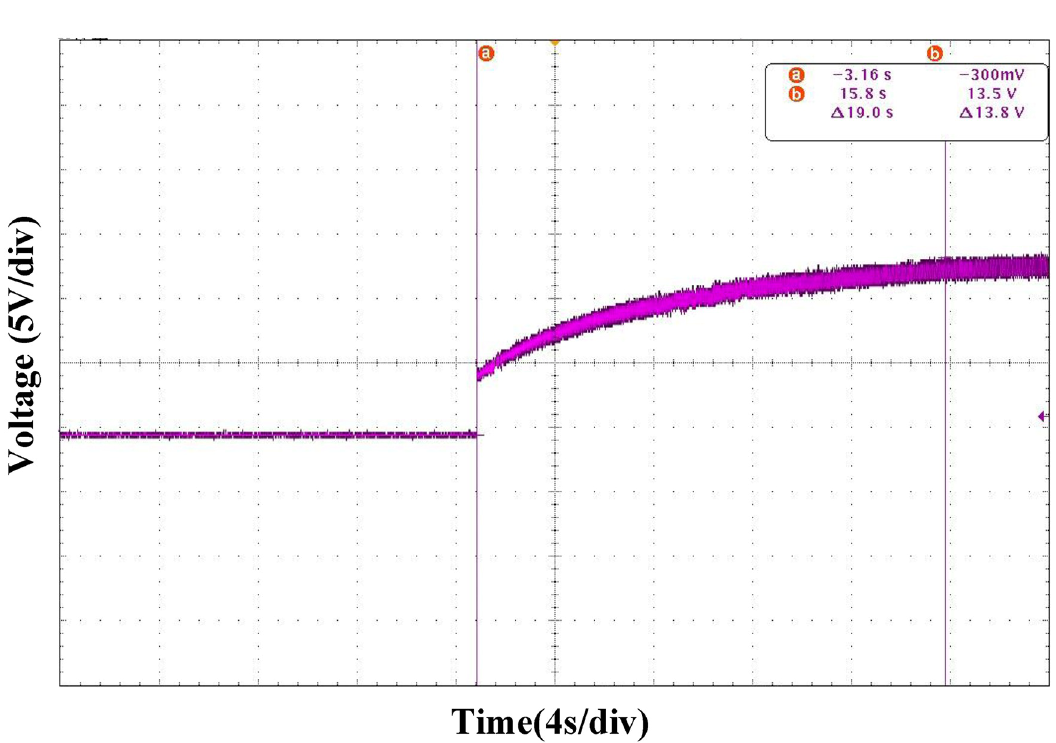
Fig 23. Startup waveform under PI control strategy.